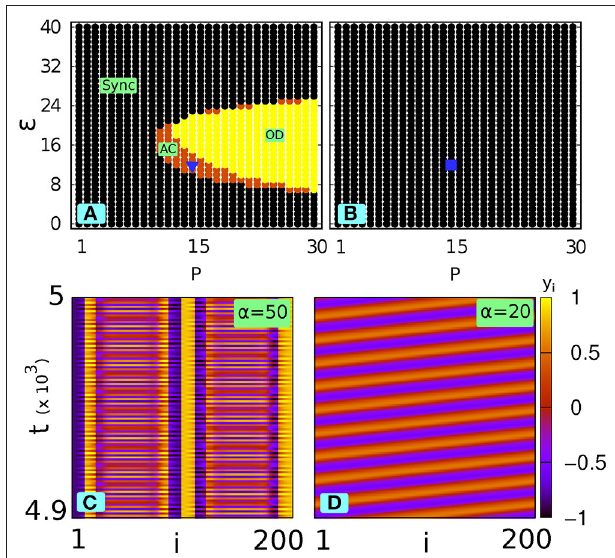
ε space for (A) − 20 (shown by (cid:4) in B ). In both =